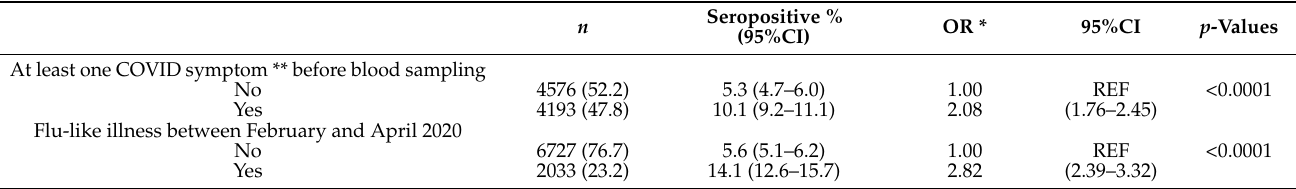
Table 3. Associations between previous self-reported COVID-19 suspected symptoms or a flu-like illness between February– April 2020 and seropositivity-CSS workers.